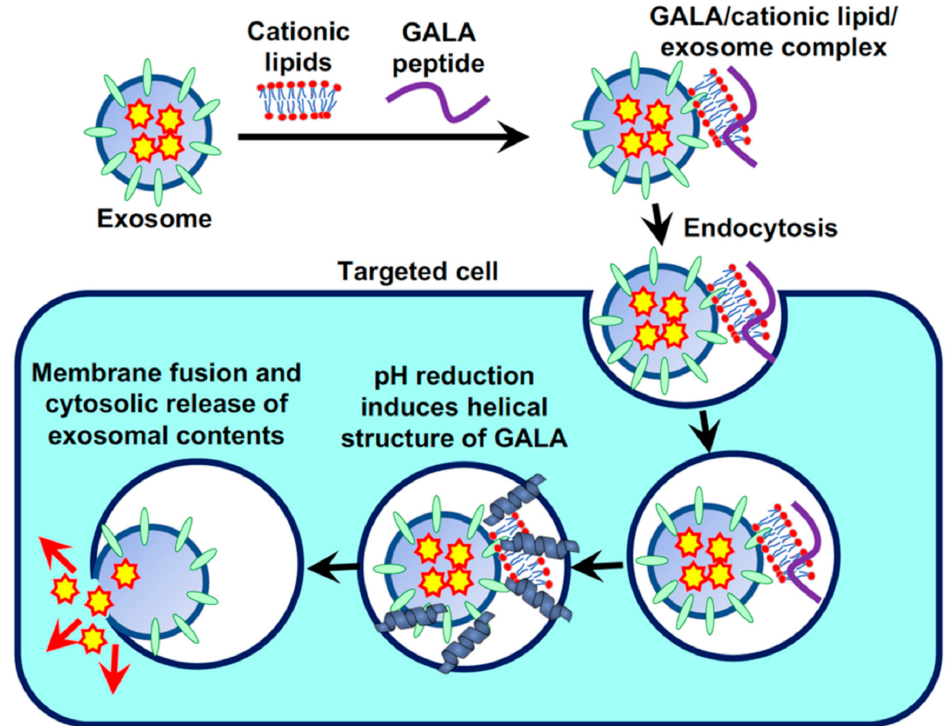
Figure 4. Enhanced cellular uptake and cytosolic release of exosomal contents by combinational treatment of pH-sensitive fusogenic peptide, GALA, and cationic